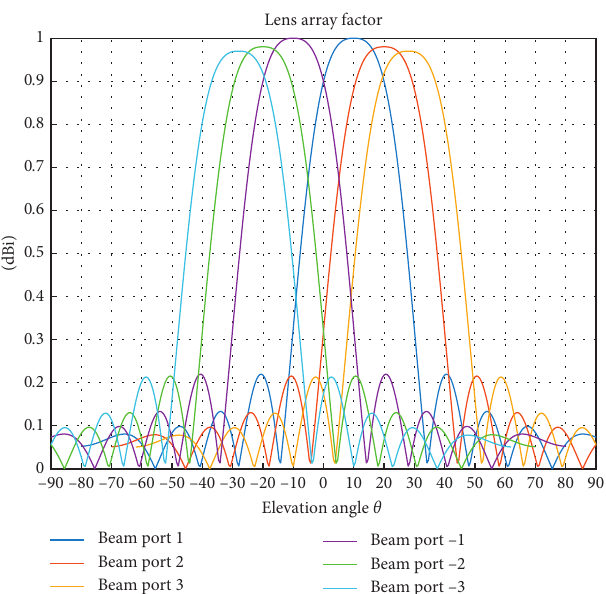
Figure 23: Rotman lens array factor rosette.